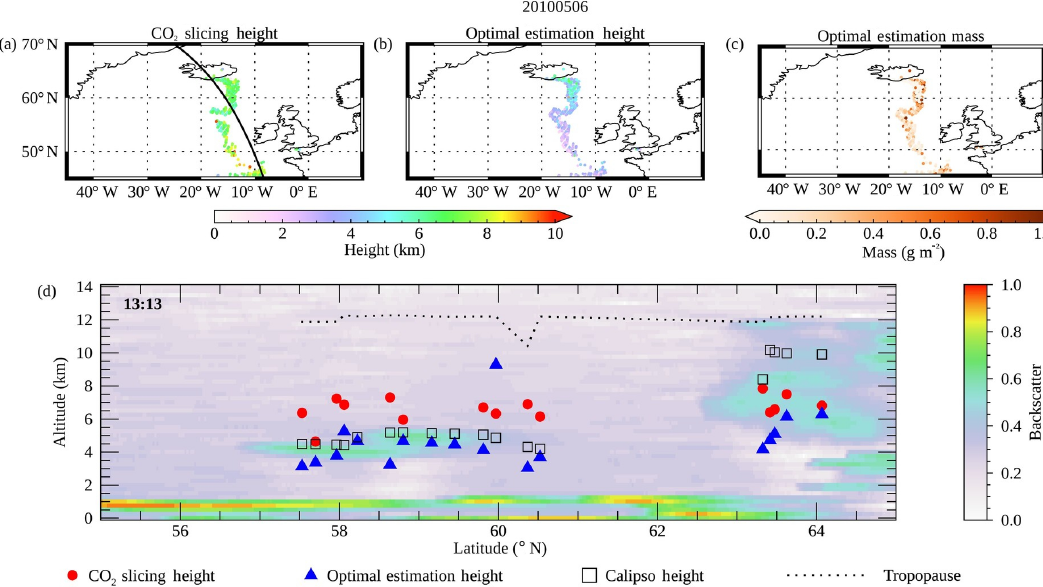
Figure 10. (a) CO 2 slicing results for 6 May 2010. Overplotted on this is the CALIPSO track. (b) The optimal estimation scheme heights. (c) The ash mass obtained with the optimal estimation scheme. (d) The CALIOP backscatter plot, with the CO 2 slicing results and the optimal estimation scheme heights plotted on top. Indicated on the top left-hand side of the plot is the time of the CALIOP overpass. The dashed line indicates the height of the